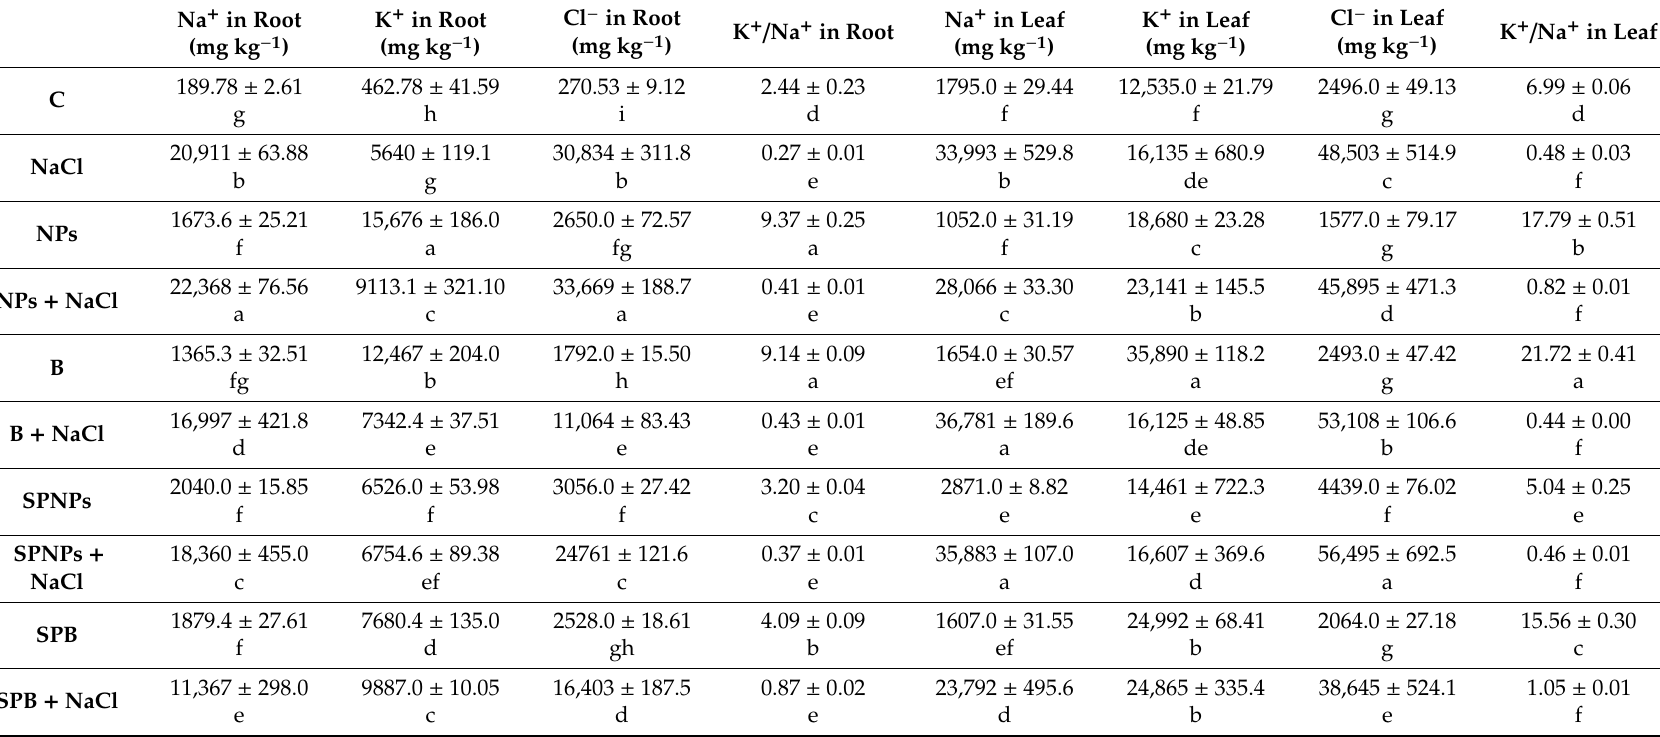
Table 1. Na + , K + , and Cl − concentration (mg kg − 1 ) in root and leaf of T. turgidum L. ssp. durum cv. Cappelli without priming and salt treatment (C), with salt treatment without priming (NaCl), with ZnO treatment in the root zone (nanoparticles, NPs or bulk form, B), with ZnO priming in the root zone with salt treatment (NPs + NaCl or B + NaCl), with ZnO treatment as a leaf spray (SPNPs or SPB), and with ZnO priming as a leaf spray with salt treatment (SPNPs + NaCl or SPB +